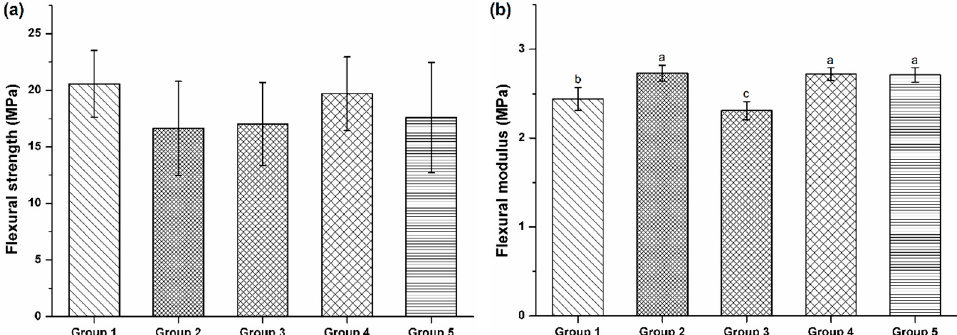
Figure 2. Flexural strength and modulus of the five experimental groups. ( a ) Flexural strength was not significantly different ( p > 0.05, Tukey HSD test); ( b ) The elastic modulus of Group 3 was significantly lower than that of the other groups, whereas Groups 2, 4, and 5 were similar ( p > 0.05, Tukey HSD test).